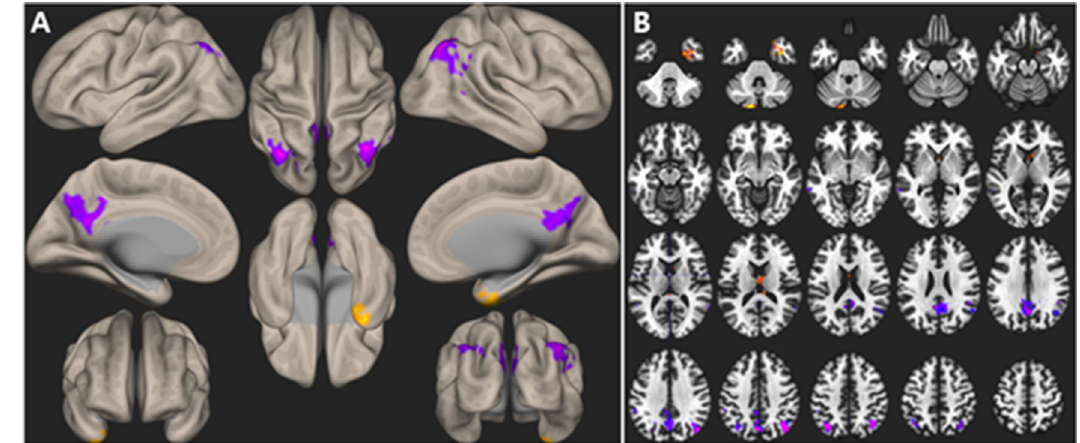
Figure 4. ALFF results. In the DMN area, ALFF was significantly lower during swallowing tasks than during non-swallowing tasks. In contrast, ALFF in the medial thalamus, right anteromesial temporal lobe, and left inferior semilunar lobule of the cerebellum were significantly higher. Statistical significance was set at FDR- corrected p < 0.05. ALFF, amplitude of low-frequency fluctuations; DMN, default mode network; FDR, false discovery rate.